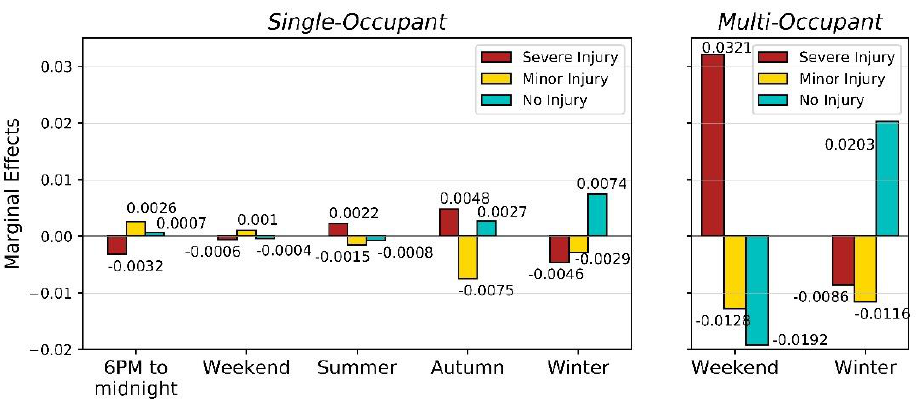
ff ects of Temporal Figure 6. Estimated marginal effects of Temporal Characteristics. Figure 6. Estimated marginal e